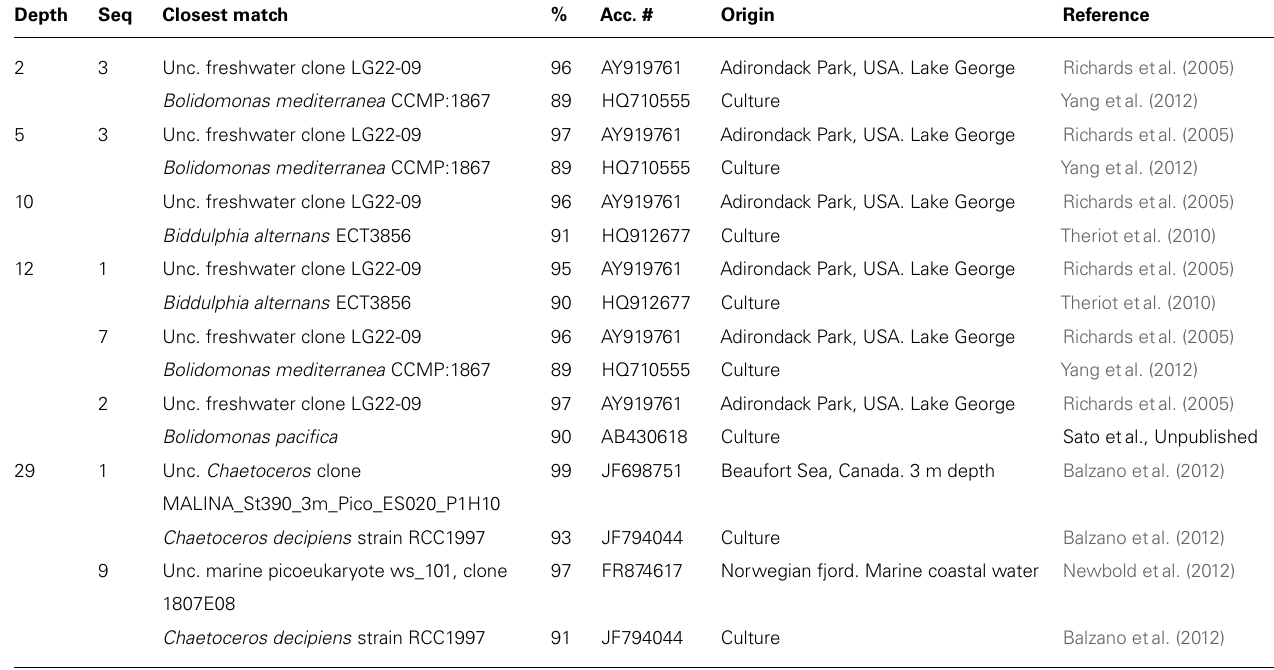
FIGURE 4 | Sequences of genera showing seasonal stability within Lake A in May 2008,August 2008, and July 2009. The bar graphs represent the dinoflagellate (A–C) and diatom genera (D–F) . Mixolimnion depths are above